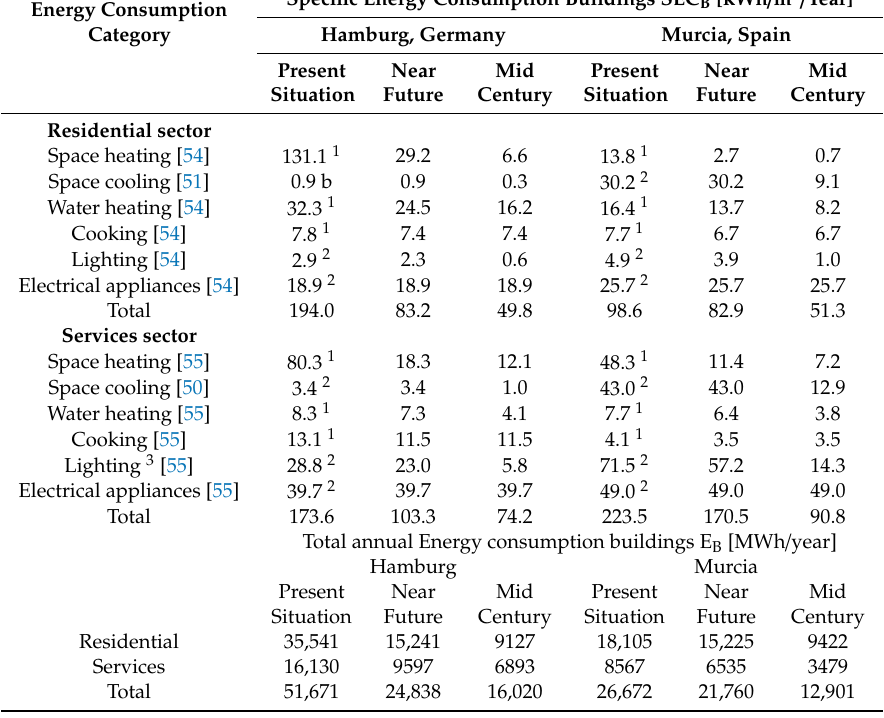
Table A4. Specific annual energy consumption SEC B (kWh / m 2 / year) per energy consumption category and total annual energy consumption E B (MWh / year) in buildings for the residential and the services sector for the Hamburg- and Murcia-based smart city areas at Present and the Near Future and Mid Century